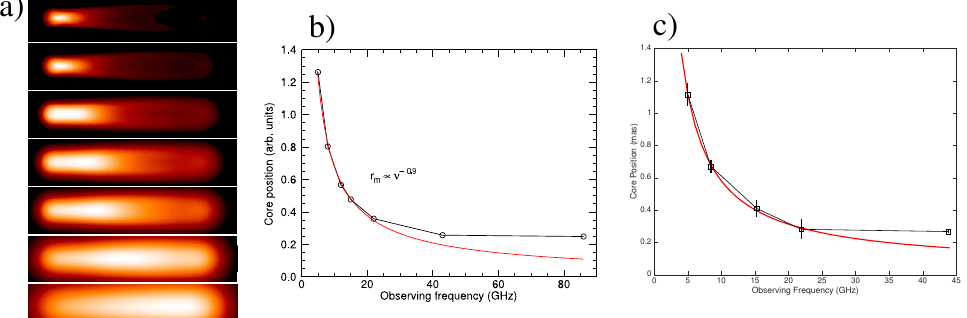
Figure 2. ( a ) A sequence of simulated synchrotron total intensity images computed at 86, 43, 22, 15, 12, 8, and 5 GHz, respectively, using a relativistic hydrodynamical model of a jet with a recollimation shock; ( b ) Position of the simulated core as a function of frequency. The red curve indicates the best fit to the core positions between 5 and 22 GHz, which follows the canonical Blandford & Königl jet model. The 43 and 86 GHz data clearly deviate from the opacity core-shift curve, revealing the recollimation shock; ( c ) Astrometric core-shifts of BL Lac between 4.8 and 43 GHz, plotted as a function of frequency, adapted from Dodson et al. [30]. Overlaid in red is the model from the fitting of the cm-wavelength data (where κ is − 0.99 and r 0 is 5.3 masGHz κ